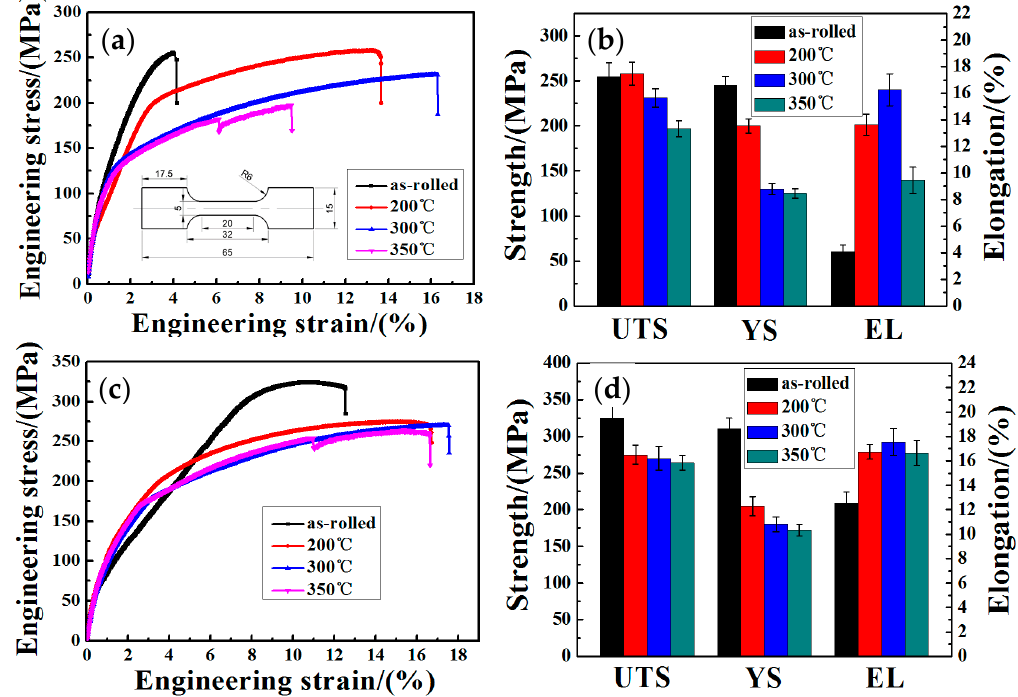
Figure 13. The engineering stress-strain curves and histograms of the flattened samples: ( a , b ) RD; ( c , d ) TD.